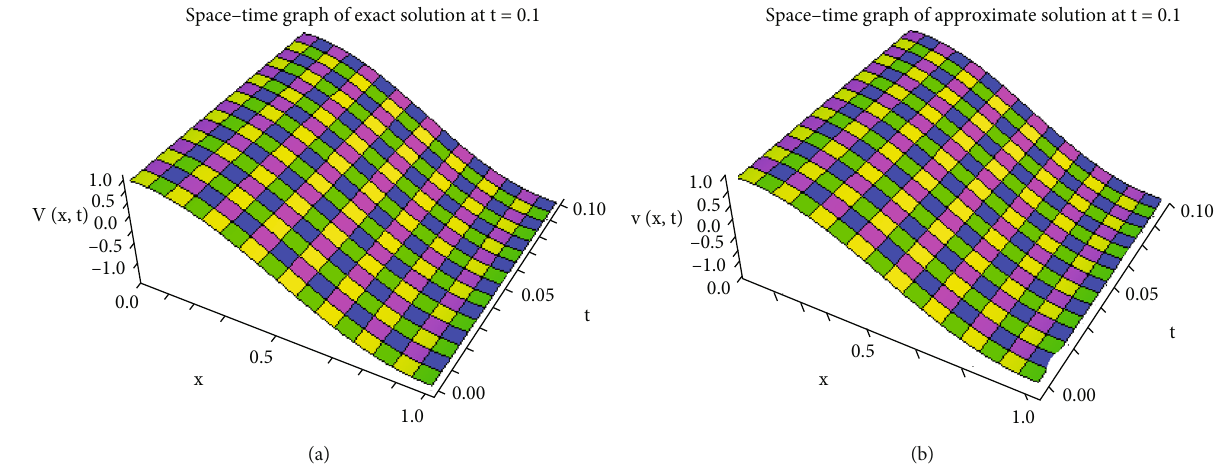
Figure 8: The approximate and exact solutions for Example 7 when h = 1/60, t = 0 : 1, Δ t = 0 : 01 .